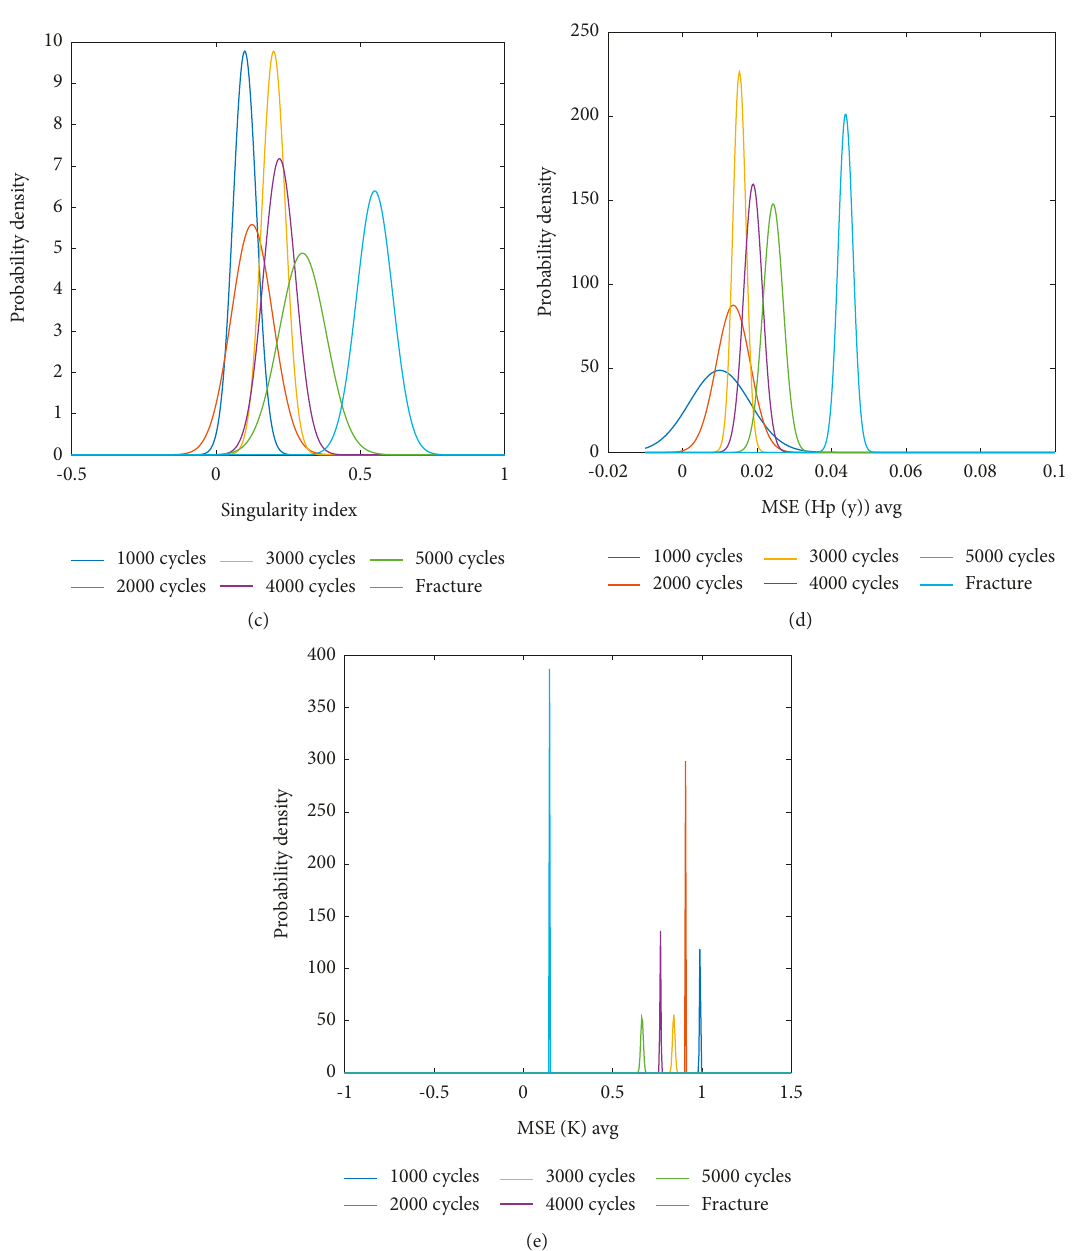
Figure 13: The prior probability distribution of the magnetic-acoustic feature parameters for each fatigue damage state. (a) Cumulative ringing count. (b) Energy (proportion of frequency band 1). (c) Amplitude (singularity index). (d) MSE( H p ( y ))avg. (e) MSE( K )avg.